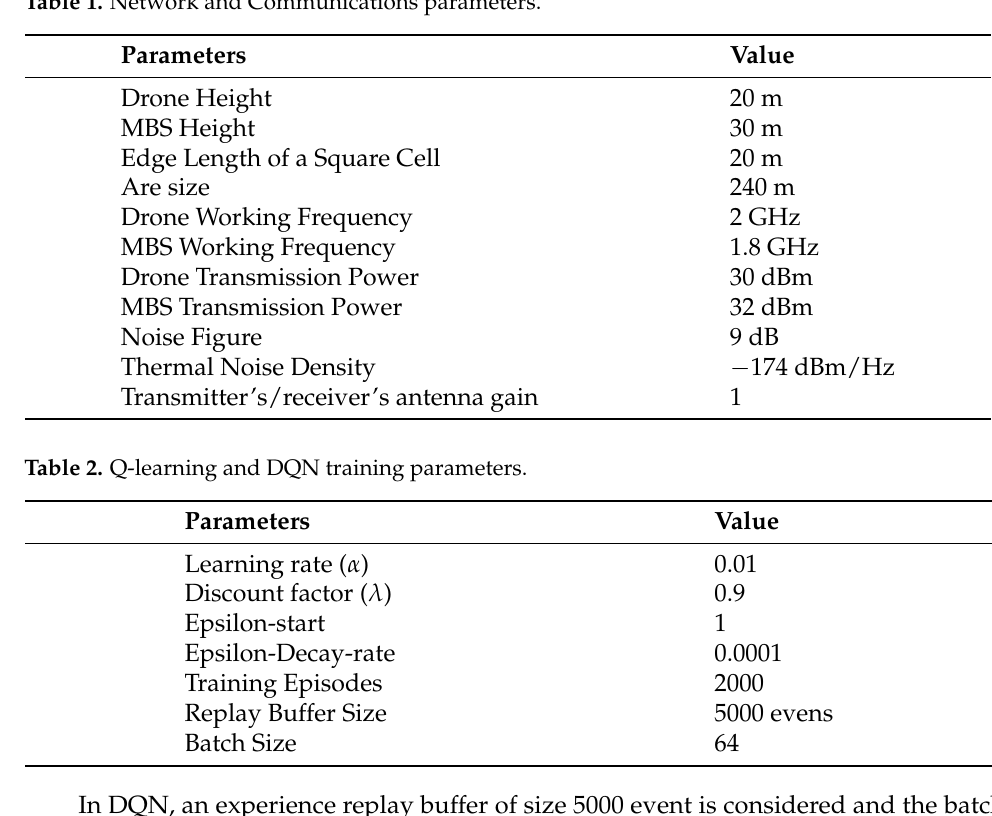
Table 1. Network and Communications parameters.